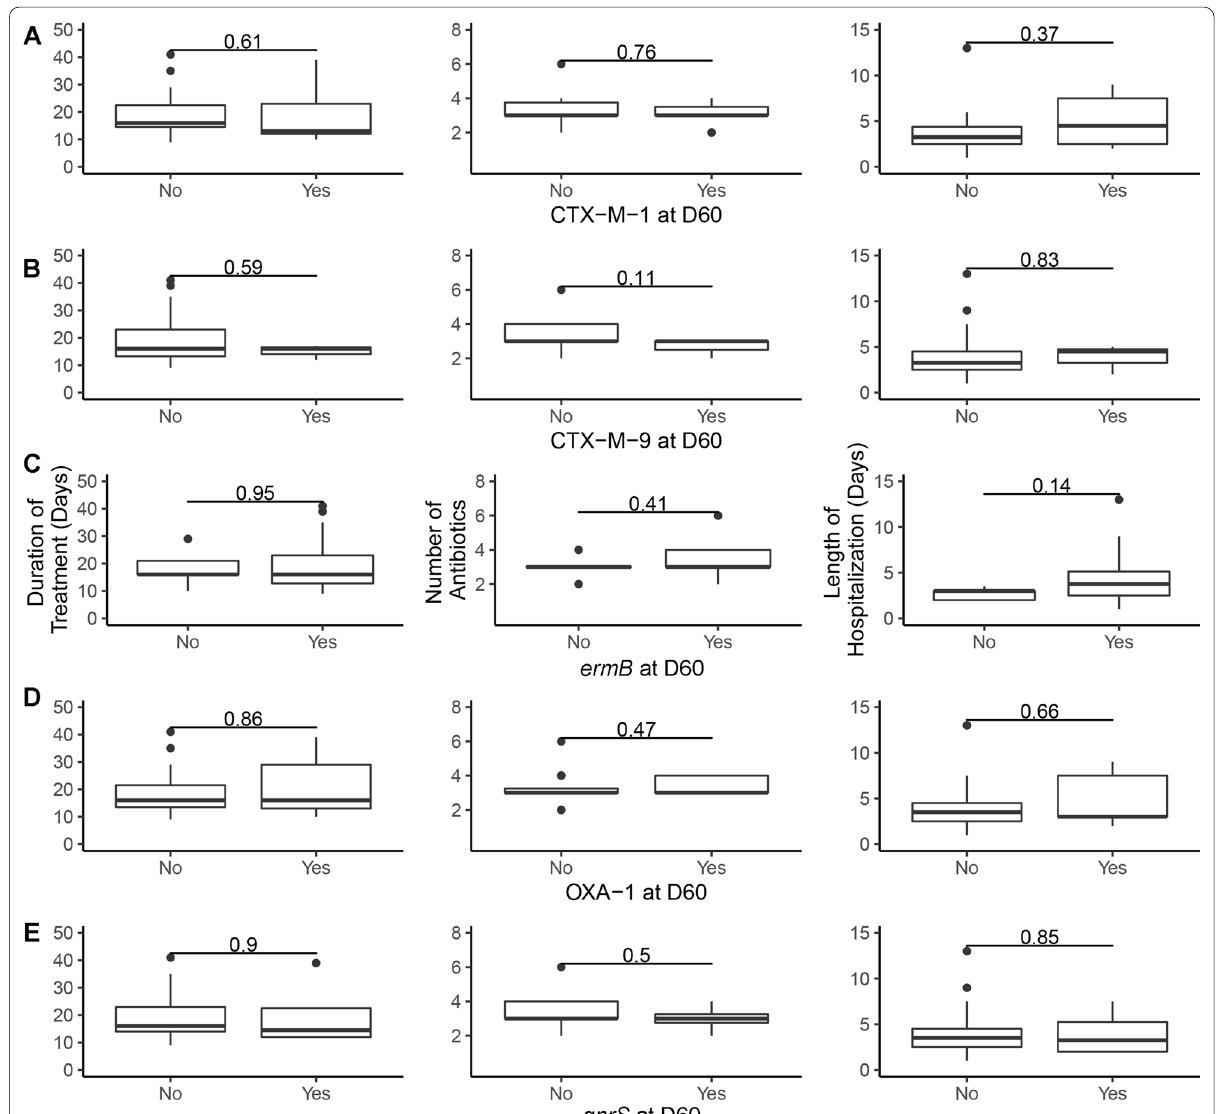
Fig. 7 Whisker plot showing the lack of association of duration of antibiotic treatment (left panels), number of antibiotics administered (middle panel), and length of hospitalization (far right panel) and recovery of AMR genes at Day 60 (panels A to D for CTX‑M‑1; CTX‑M‑9; erm B, OXA‑1